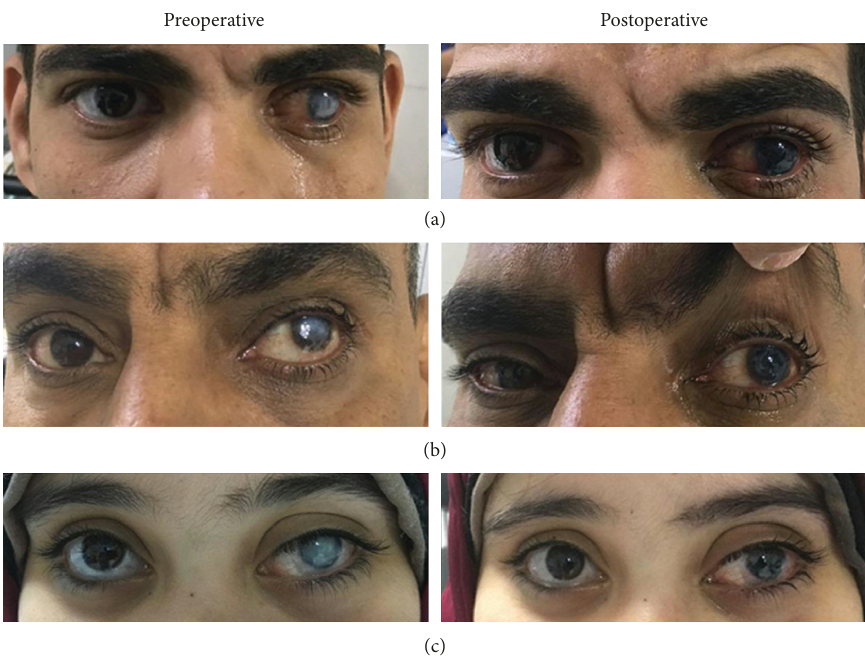
Figure 3: (a) Pretattooing and posttattooing (3 months) external pictures of a 32-year-old male. (b) Pretattooing and posttattooing (one month) external picture of a 62-year-old male. (c) Pretattooing and posttattooing (three months)external picture of a 18-year-old